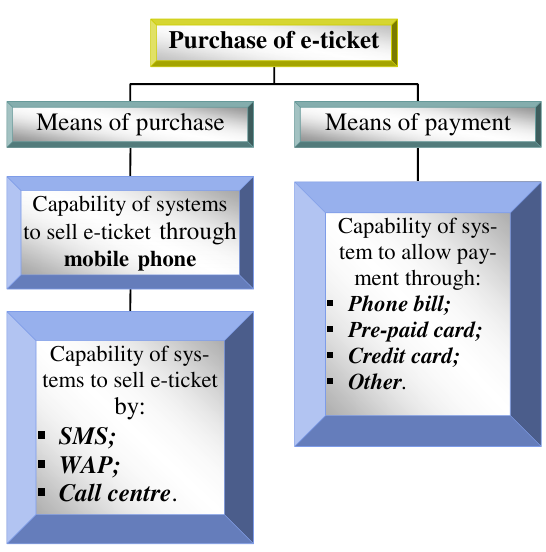
Fig 6. Purchase of e-ticket